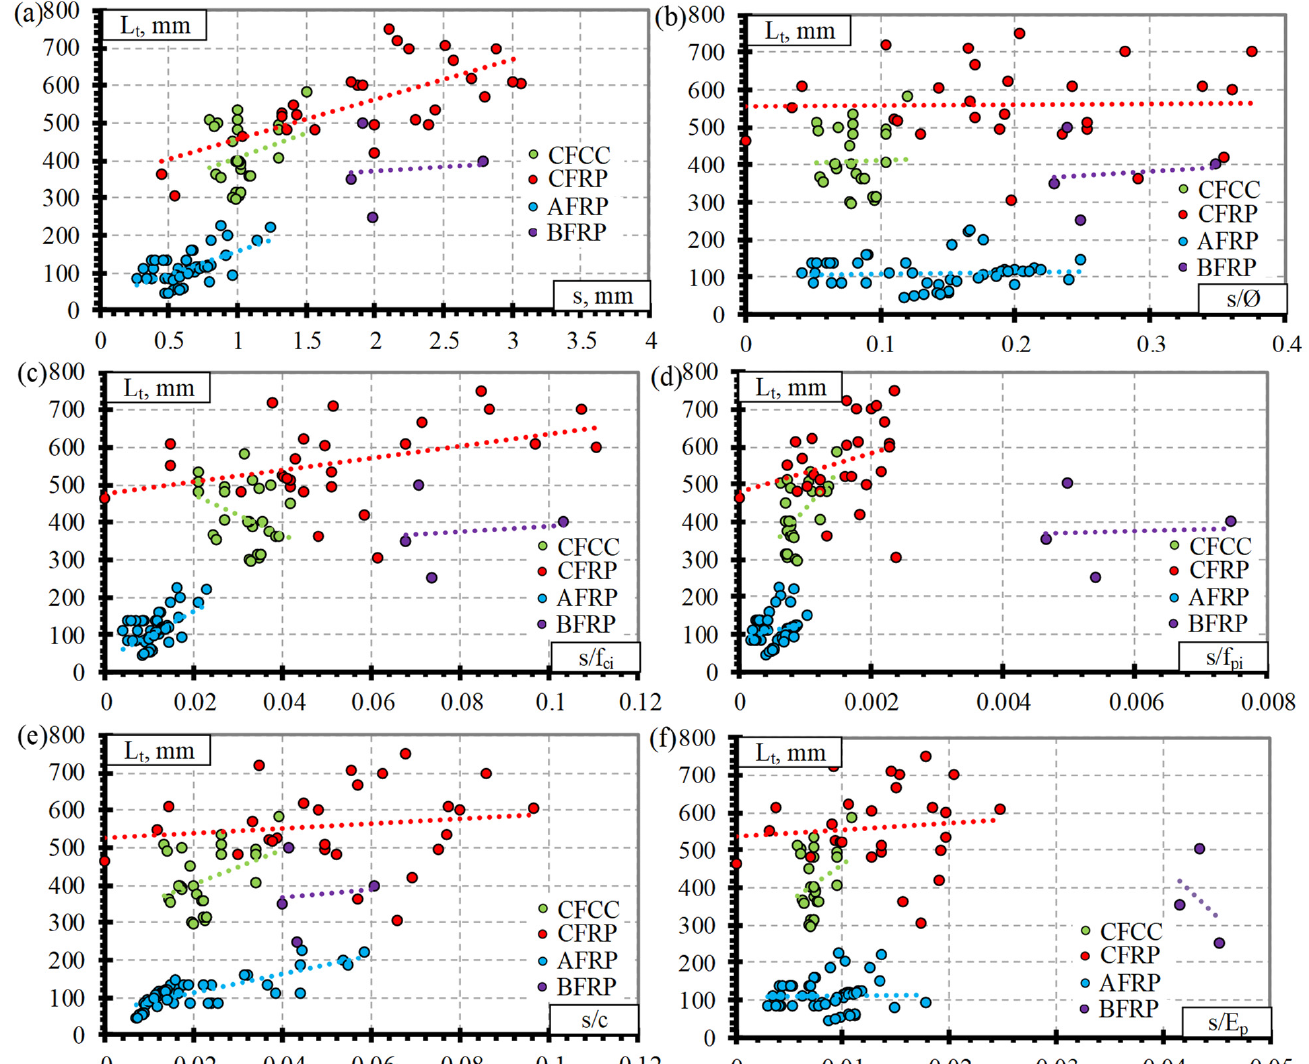
Figure 3. Comparison between transfer length of different FRP reinforcements and: ( a ) slip, ( b ) s/Ø, ( c ) s/f ci , ( d ) s/f pi , ( e ) s/c, ( f ) s/E p